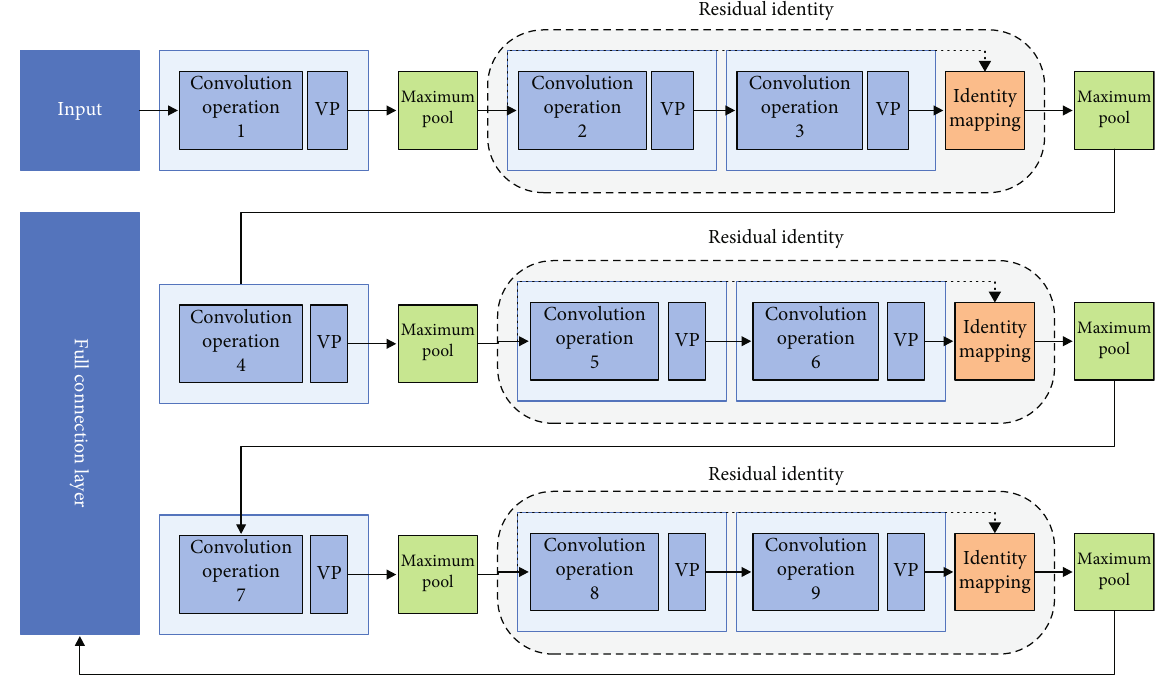
Figure 2: Convolutional neural network based on visual priority rules and residual